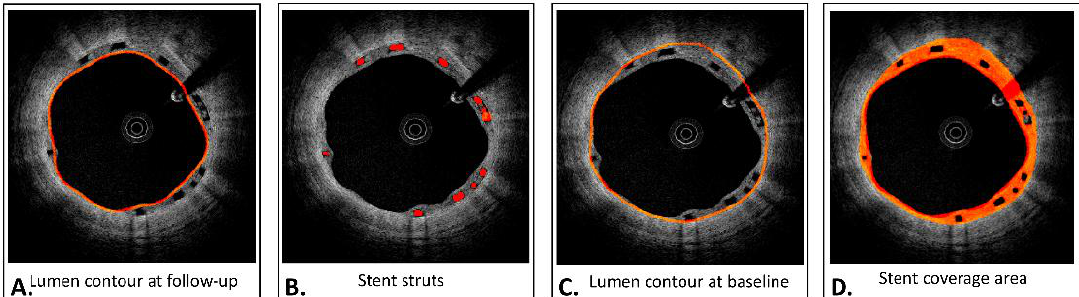
Figure 3. Definition of lumen contour at 9-months follow-up ( A ), stent struts ( B ), and at baseline ( C ). The restenosis area ( D ) was obtained from the pixels between contours that were subtracted with the stent struts.